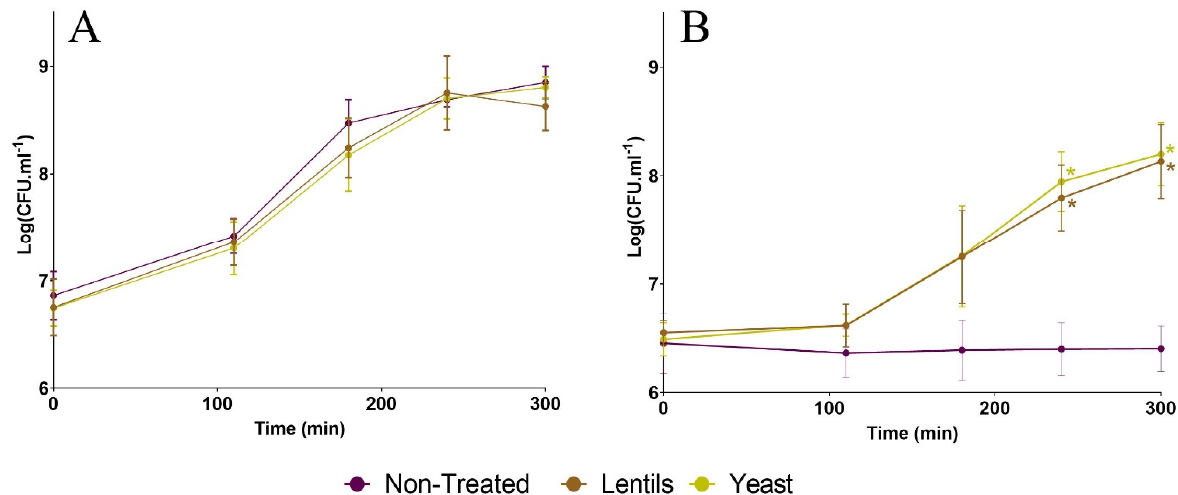
Figure 1. Impact of fiber-containing products on ETEC growth in broth media. Growth kinetics of ETEC strain H10407 (inoculation at 10 7 CFU · mL –1 ) in LB medium ( A ) or in M9 minimal medium ( B ) supplemented with specific yeast cell walls (yellow line, ‘yeast’), lentils (brown line, ‘lentils’) at 2 g · L –1 , or not supplemented (purple line, ‘non-treated’). Samples were regularly collected and plated on LB agar. Results are expressed as Log 10 CFU · mL –1 (mean ± SD, n = 3). Statistical differences with the control condition are indicated and provided by Dunnett’s multiple comparisons test (*: p < 0.05).